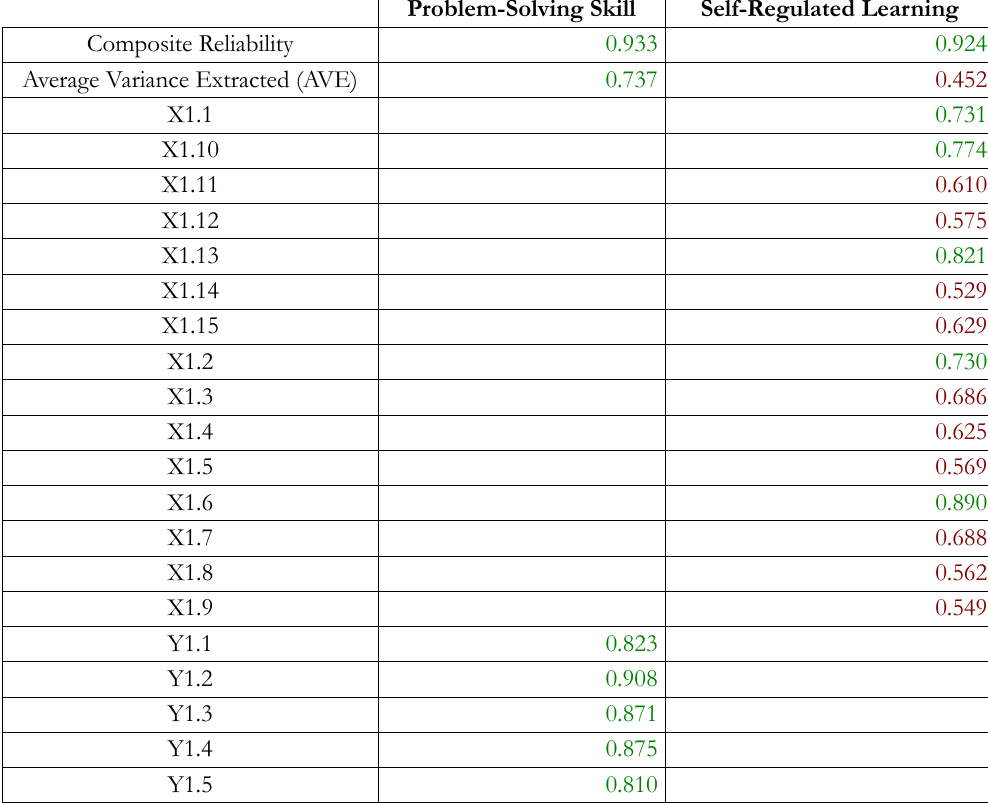
Table 2. Reflective measurement model